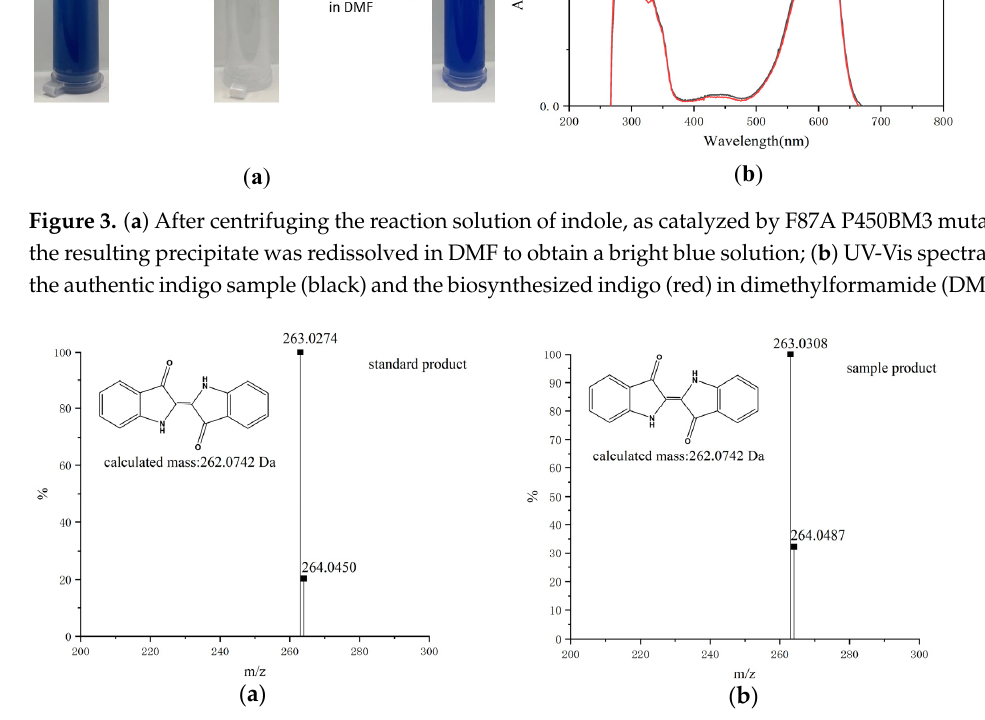
Figure 4. UPLC-MS spectra of the oxidation product of standard product ( a ) and indole in precipi- tation catalyzed by F87G/T268V P450BM3 mutant ( b ). Indigo (C 16 H 10 N 2 O 2 ), Calculated: 262.0742 Da; Observed: 263.0308 Da ([M+H] + ).